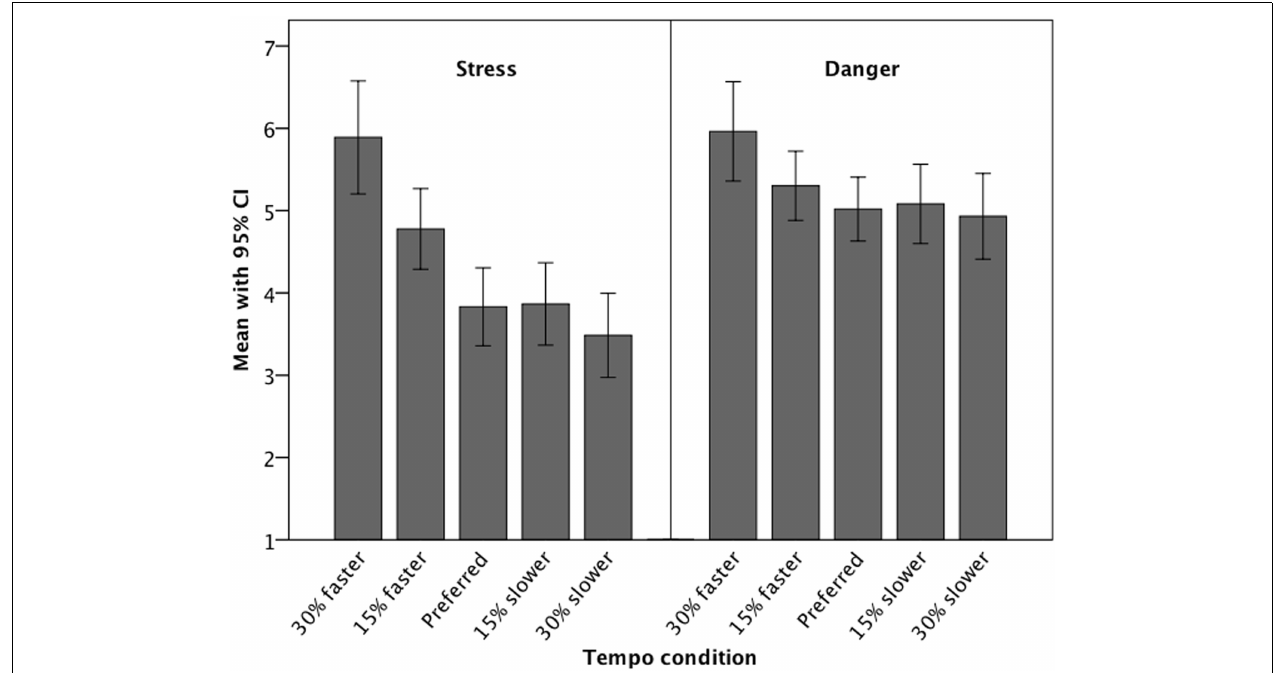
FIGURE 1 | Means (and 95% confidence intervals) of stress and danger ratings for the five tempo conditions (simple, moderate, and complex rhythms are